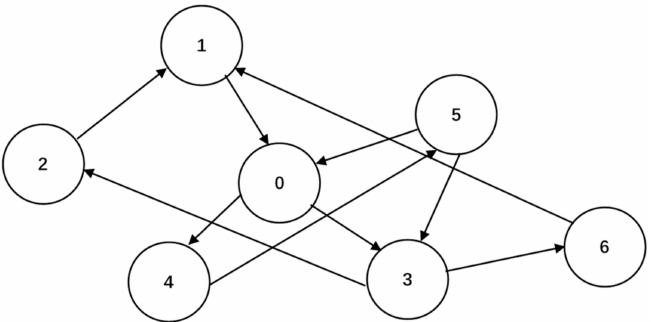
Figure 6. The spatial interaction network corresponding to the spatial interaction records in Figure